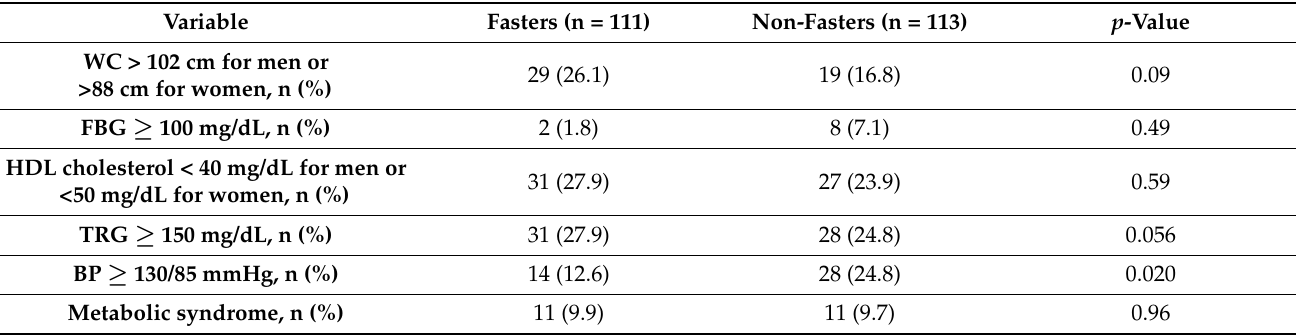
Table 2. Prevalence of metabolic syndrome and its